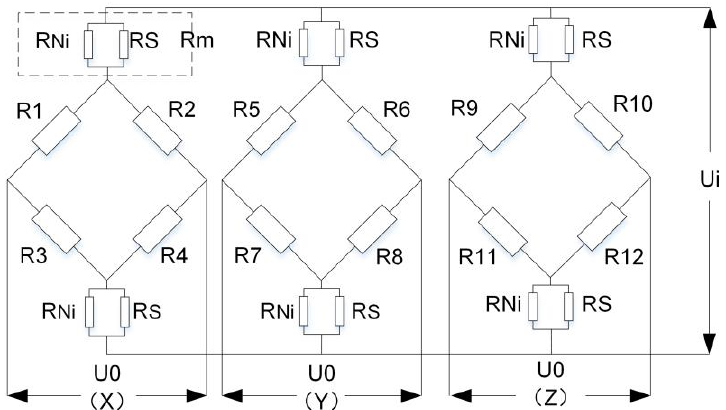
Figure 3. Strain gauge arrangement and measuring circuit.